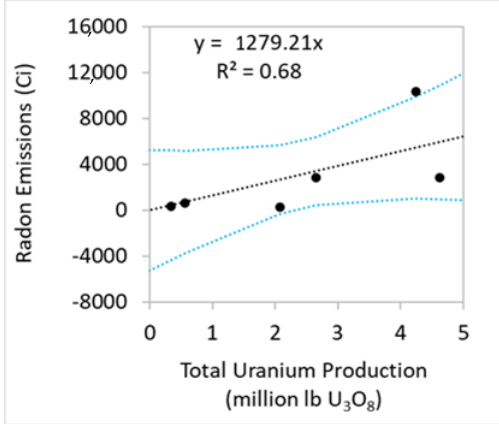
Figure 12. Radon emitted (Ci) as a function of uranium produced (as lb U 3 O 8 ) for the six ISR operations listed in Table A1. Compiled data used to construct this graph are derived from Table A7. Black line is the linear trend line and blue lines are the 95 percent confidence intervals.